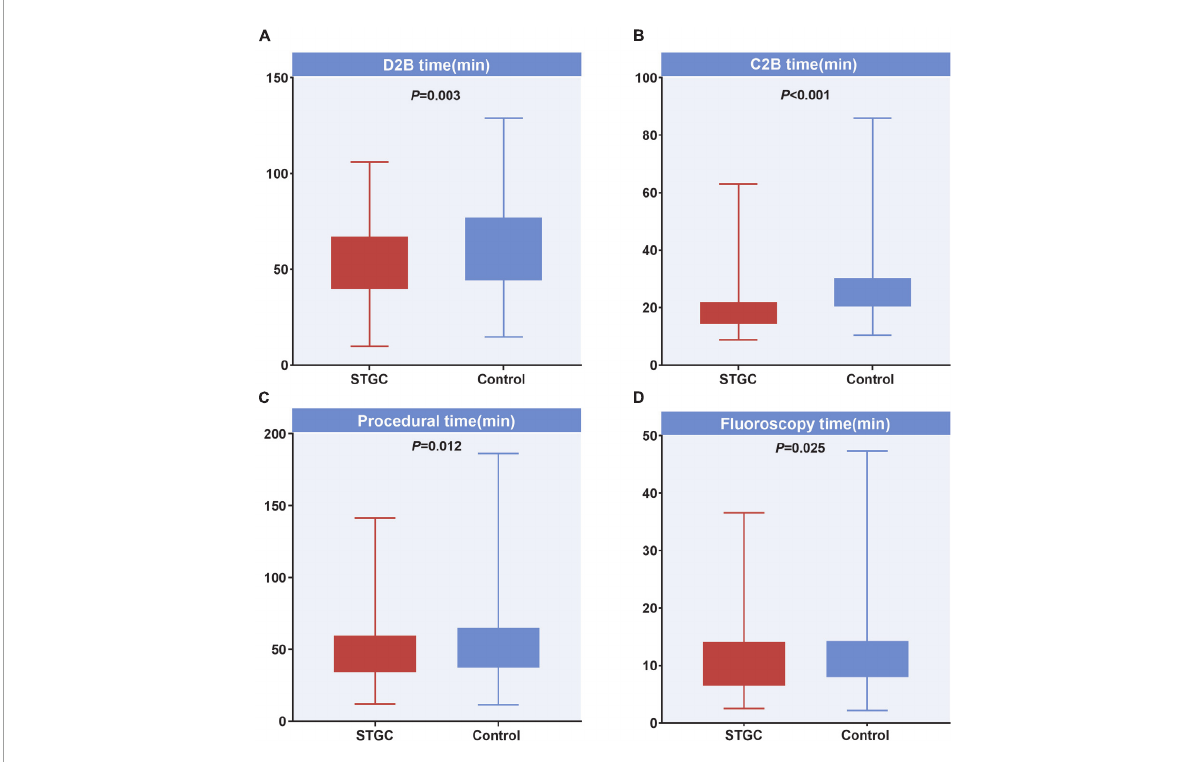
FIGURE2 Difference of treatment time between two groups. (A) D2B time, (B) C2B time, (C) procedural time, and (D) fluoroscopy time. C2B, catheterization laboratory door-to-balloon; D2B, door to balloon; STGC, single transradial guiding catheter.